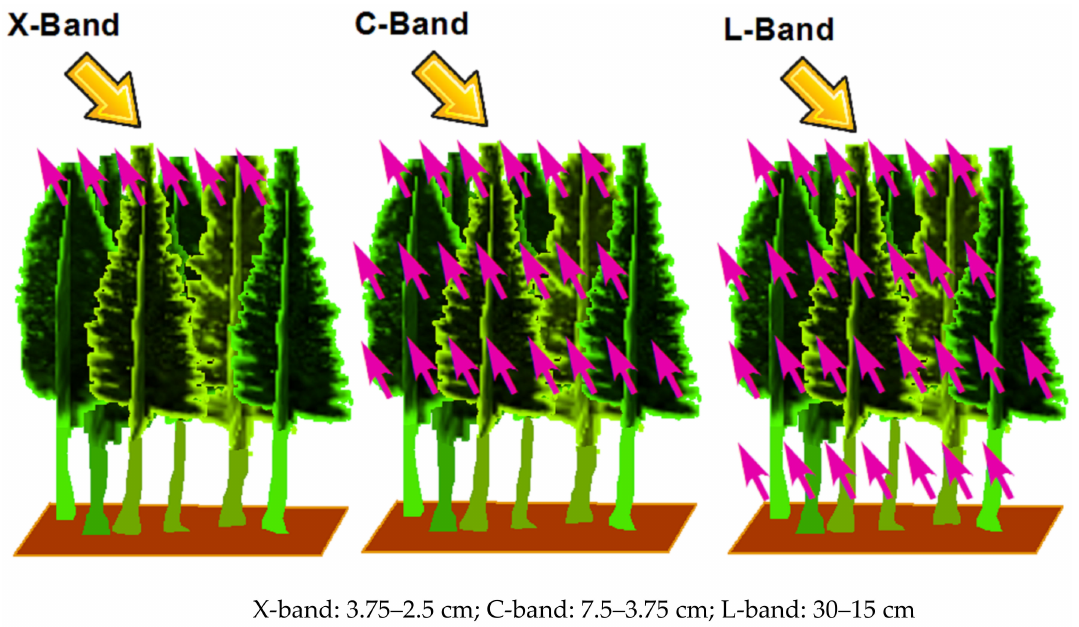
Figure 2. Wavelength illustration of multi-frequency radar system through vegetation. Source: modified from the European Space Agency (ESA